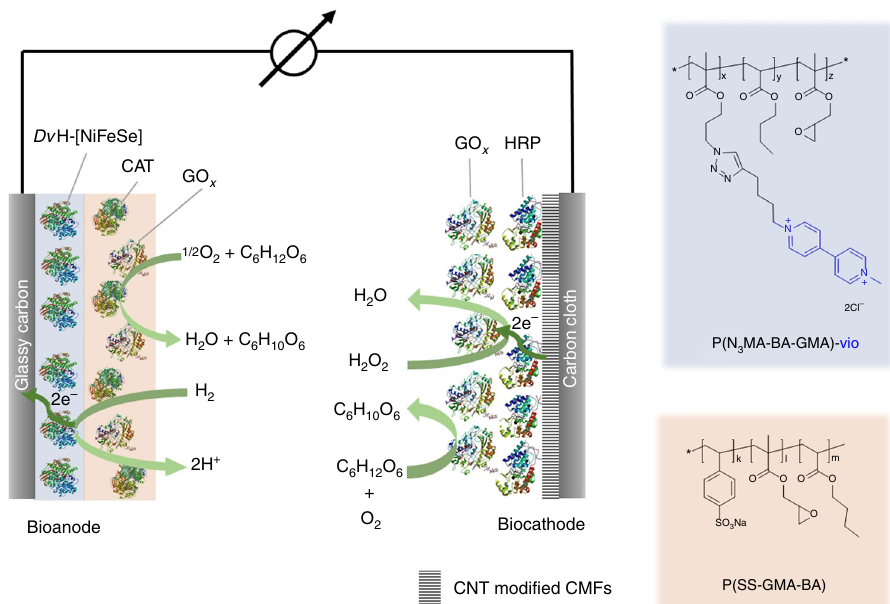
Fig. 1 Schematic of the proposed hydrogenase/horseradish peroxidase biofuel cell. The bioanode consists of a polymer double-layer system comprising an underlying layer composed of the [NiFe] or [NiFeSe] hydrogenase from Desulfovibrio vulgaris Miyazaki F ( Dv MF-[NiFe]) and from Desulfovibrio vulgaris Hildenborough ( Dv H-[NiFeSe]) integrated into the viologen-modi fi ed polymer P(N 3 MA-BA-GMA)-vio (poly(3-azido-propyl methacrylate- co -butyl acrylate- co -glycidyl methacrylate)-viologen (the viologen moieties are depicted in blue) and a protection top layer consisting of a bienzymatic system that contains an oxidase (glucose oxidase, GOx, or pyranose oxidase, Py 2 Ox) and catalase (CAT) embedded in the redox-silent polymer P(SS-GMA-BA) (poly (4-styrene sulfonate- co -glycidyl methacrylate- co -butyl acrylate)). Oxygen is removed by converting glucose to gluconolactone by the concomitant reduction of O 2 to H 2 O 2 . The biocathode is built on a carbon cloth electrode that was modi fi ed with carbon micro fi bers (CMFs) that were decorated with carbon nanotubes (CNTs). The latter ensure wiring of the horseradish peroxidase (HRP) via the iron-oxo complex compound I. The cathode was fi rst modi fi ed with pyrene butyric acid (hydrophilization) and then via a sequential drop cast process with a HRP layer followed by a top layer containing the oxidase (GOx or Py 2 Ox) that ensures the in situ H 2 O 2 formation. Note that for clarity only the combination of a Dv H-[NiFeSe]/GOx/CAT and GOx/HRP based electrodes are shown in the